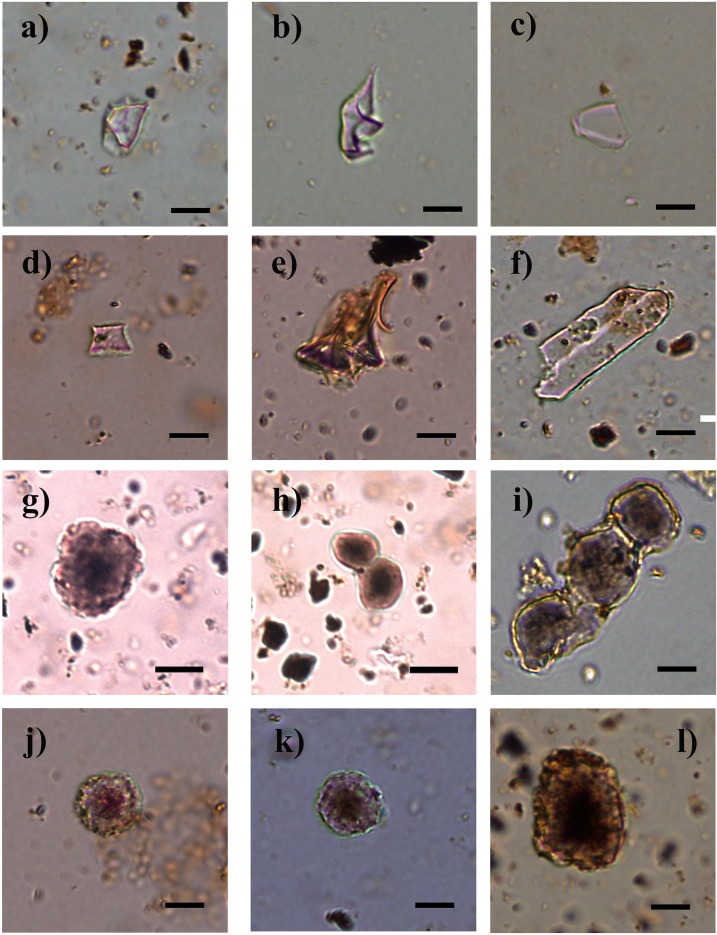
Common phytolith morphotypes.Microphotographs of common phytolith morphotypes identified in samples from different StratAggs of PP5-6N. a-c) irregular morphologies from samples 162467, 162548 and 46682 from SADBS; d-f) grass silica short cells (GSSCs): d- GSSC rondel from sample 162749 from LBSR, e- GSSC rondel tall from sample 162781 from LBSR and f- GSSC oblong tabular sinuate from sample 356455 from LBSR; g-l) restio phytoliths: g,h- sample 602414 from BAS, i- sample 356490 from SADBS, j,k- samples 162782 and 157209 from LBSR, l- sample 388612 from YBSR. Pictures taken at 400x. Scale bar represents 10 mm.